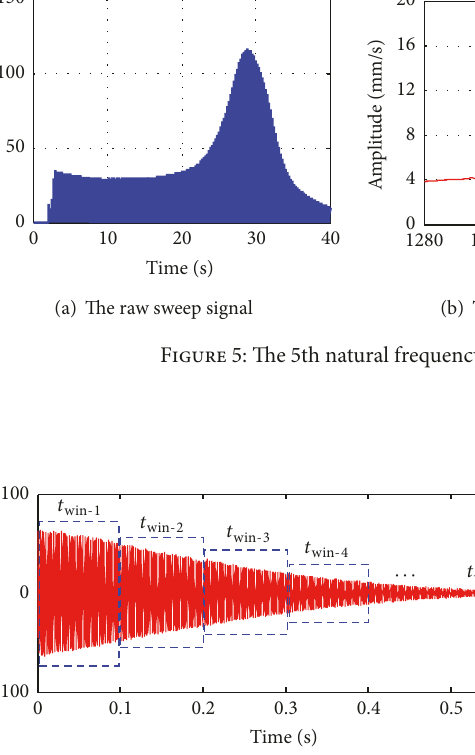
Figure 6: The 3rd time-attenuation signal of TCS without hard coating obtained by sliding-envelope